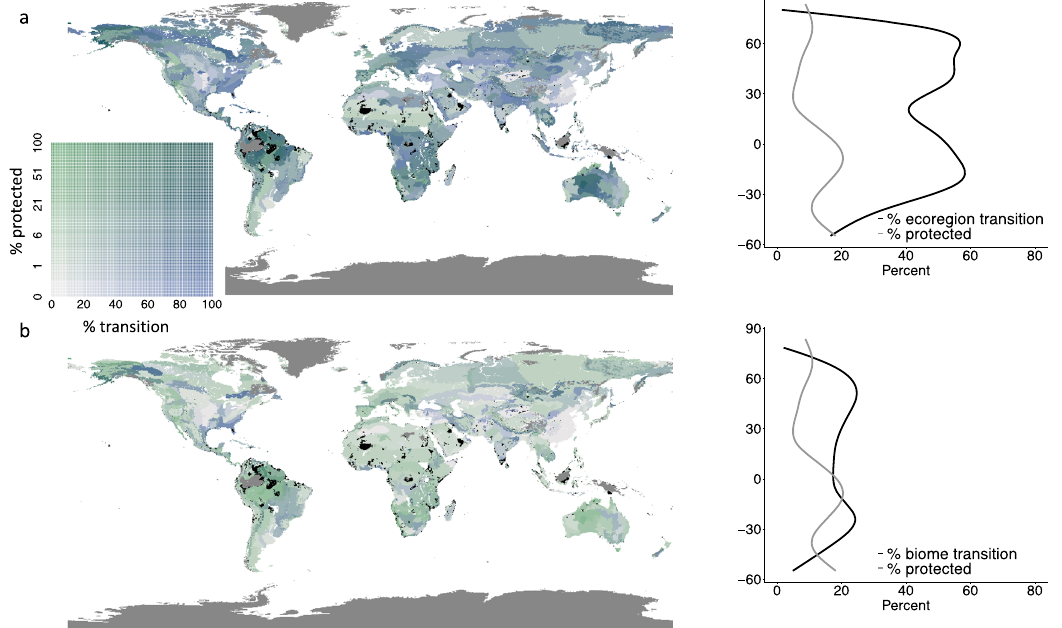
Fig. 2 Percent protection and potential climate driven transitions for ecoregions and biomes. Percent area within each ecoregion that is currently protected and is projected to transition between ecoregions ( a ) or biomes ( b ) based on a global + 2 °C warming scenario. Smoothed percent protection and transition percent by latitudinal bands (~4 km bins) are presented to the right of each map. Black areas represent no-analog conditions. Grey represents areas with insuf fi cient data (see methods), water, or ice. An interactive version of this graphic is presented online at https://umlandscape